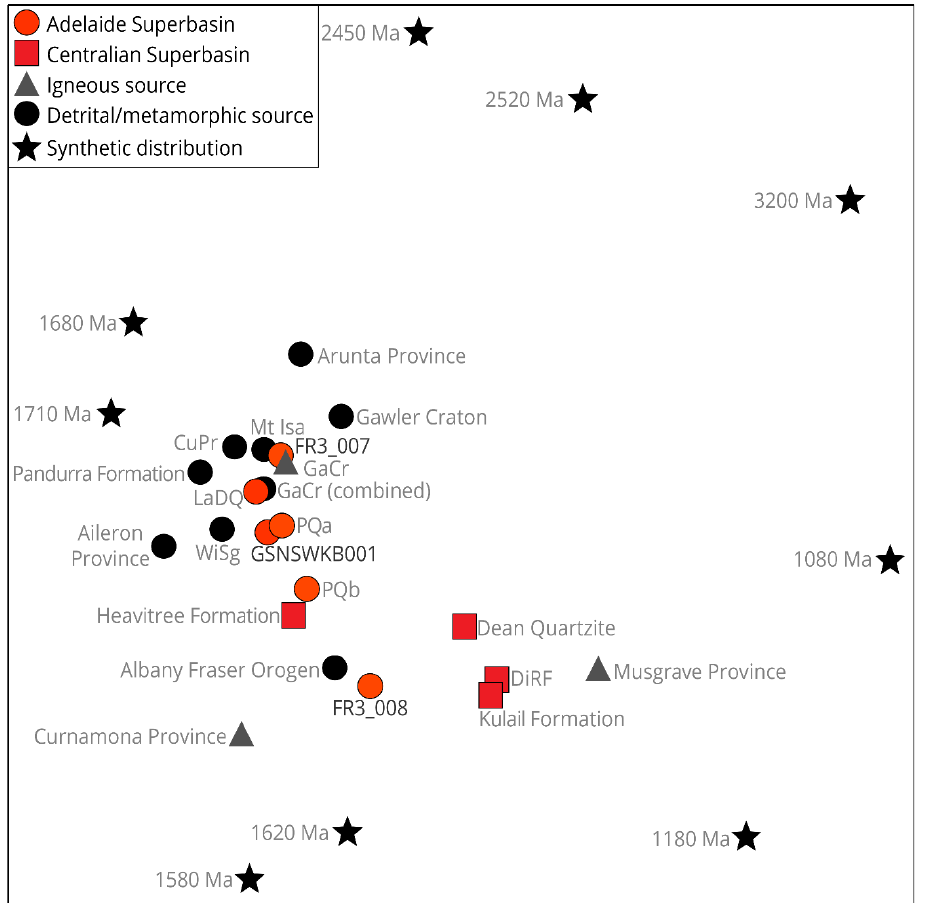
Figure 7. Non-metric multidimensional scaling plot of samples analysed (n > 40) in this study (orange circles) with data from potential correlative formations of the Centralian Superbasin (red squares), potential source regions (black and grey circles and triangles), and synthetic distributions of main population peaks and key zircon growth events in the region. This plot shows relative similarity of all data to each other and is intended as a visual guide. Points that plotted closer together suggest greater similarity. Axes were omitted, as the algorithm produced normalised values with no physical meaning which could be safely removed. Produced using IsoplotR [69]. Abbreviations: CuPr = Curnamona Province; GaCr = Gawler Craton (combined signifies detrital, metamorphic, and igneous data); WiSg = Willyama Supergroup, DiRF = Dixon Range Formation, PQ = Paralana Quartzite. Data were taken from this study and the existing literature (a = does not include Shanahan Conglomerate Member data, b = includes Shanahan Conglomerate Member data).